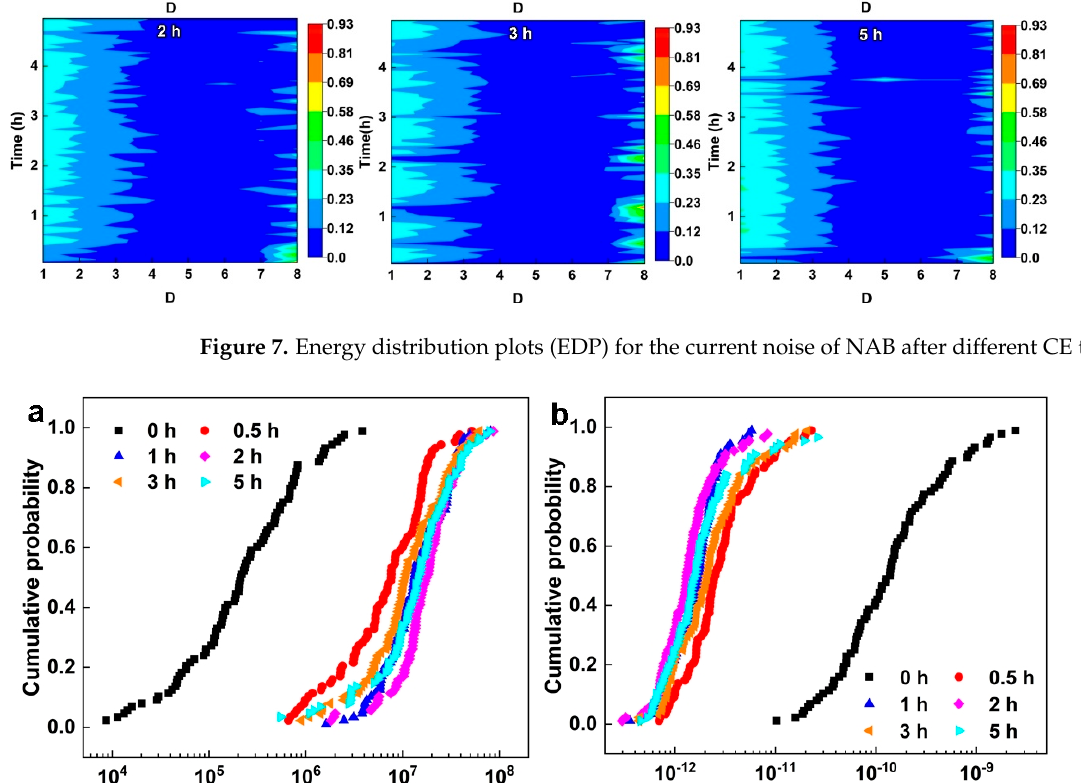
Figure 7. Energy distribution plots (EDP) for the current noise of NAB after different CE times.